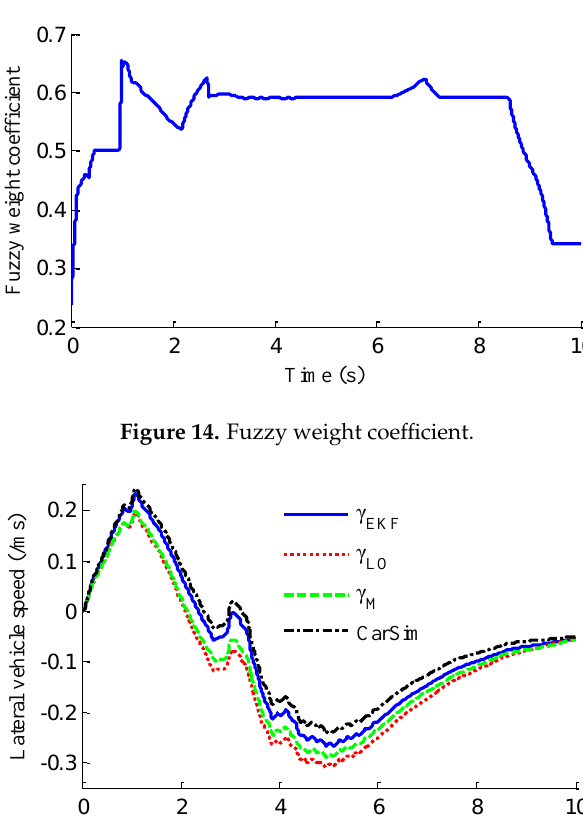
Figure 13. Estimation of longitudinal forces. ( a ) F x 1 ; ( b ) F x 2 ; ( c ) F x 3 ; ( d ) F x 4 .